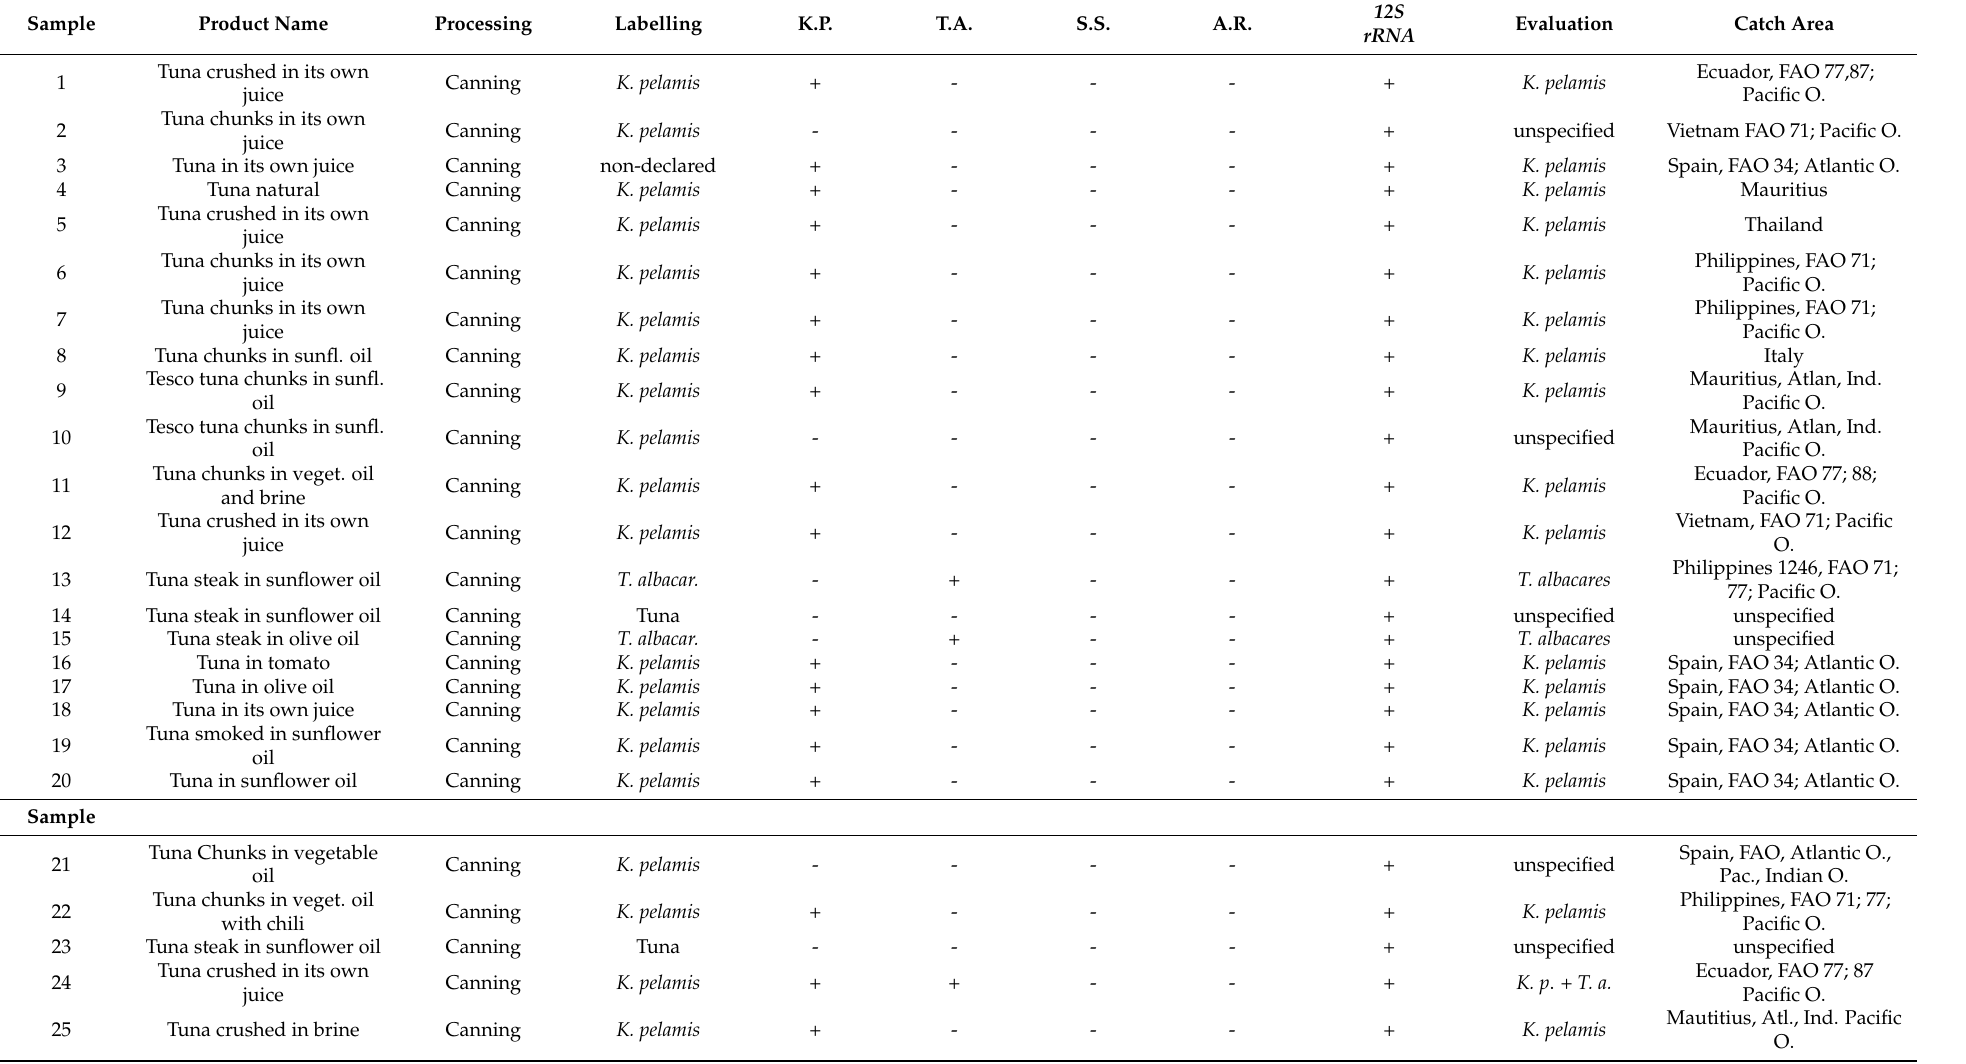
Table 3. List of examined